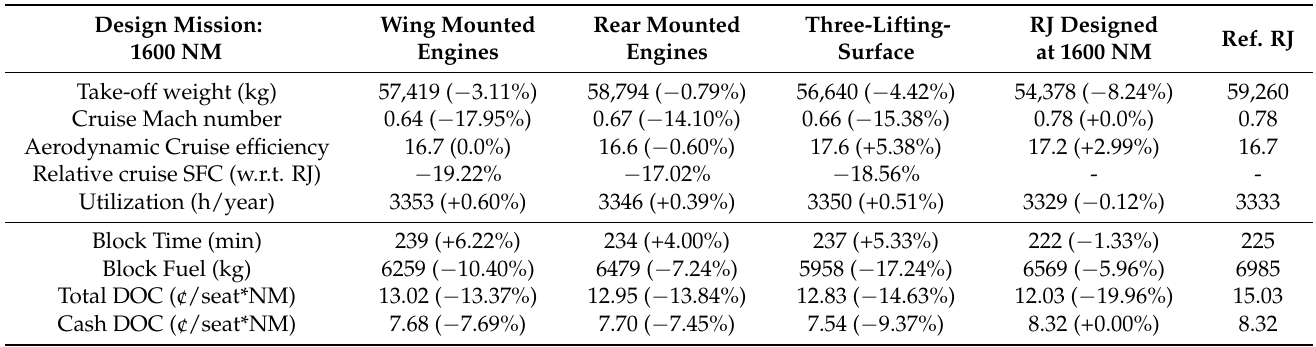
Table 7. Comparison with the reference regional jet in terms of block time, block fuel, and DOC (percent differences, in brackets, with respect to the regional jet).